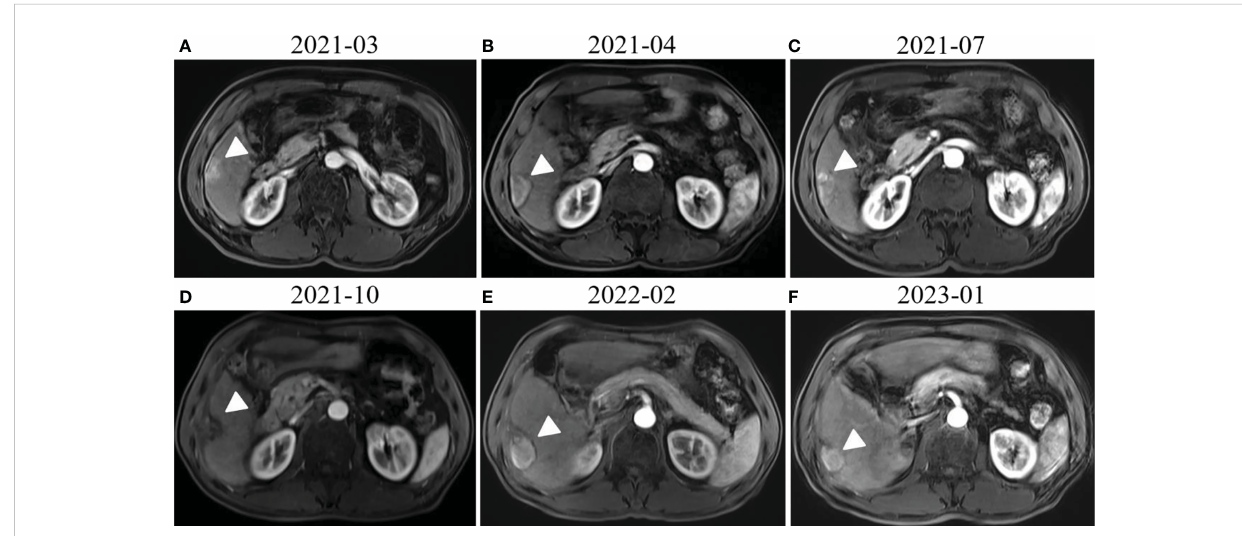
FIGURE 1 Radiological response evaluation of the liver during the clinical course. (A) Contrast-enhanced magnetic resonance imaging (MRI) revealed enhanced subcapsular hepatocellular carcinoma (HCC) lesions in the hepatic S6 (white arrowhead). (B) Contrast-enhanced MRI revealed that the lesion in hepatic S6 was not enhanced in the arterial phase (white arrowhead) 1 month after transcatheter arterial chemoembolization (TACE) and radiofrequency ablation (RFA). (C) An enhanced small nodule around the previous one (white arrowhead) was detected by MRI three months after TACE and RFA. (D) Contrast-enhanced MRI showed no active lesions in the liver (white arrowhead) 3 months after surgical resection of the liver metastases. (E) Complete response (CR) was con fi rmed by contrast-enhanced MRI, which showed no active lesions in the liver (white arrowhead) after RFA and four cycles of tislelizumab treatment. (F) MRI obtained 15 months after tislelizumab treatment initiation showed that there were still no active lesions (white arrowhead) in the liver or new